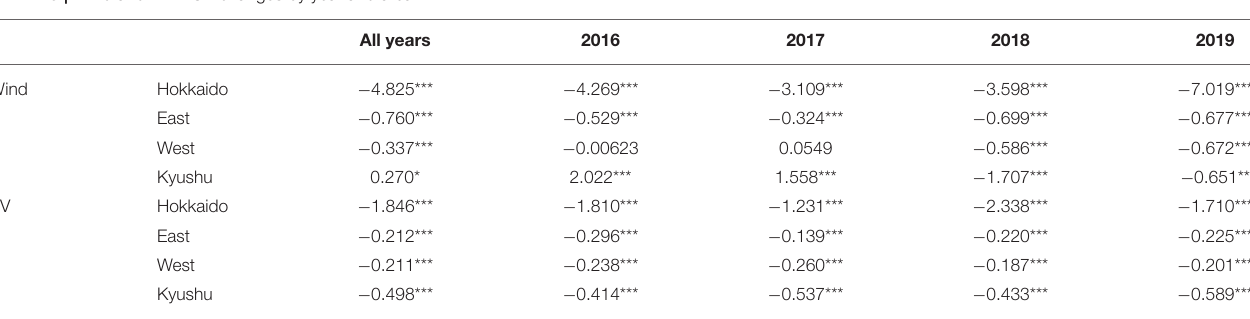
TABLE 3 | Wind and PV MOE changes by year and area.